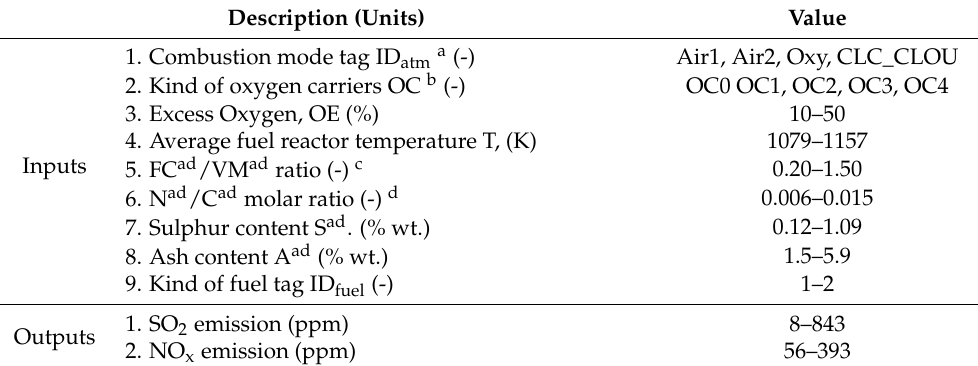
Table 3. Parameters of entry